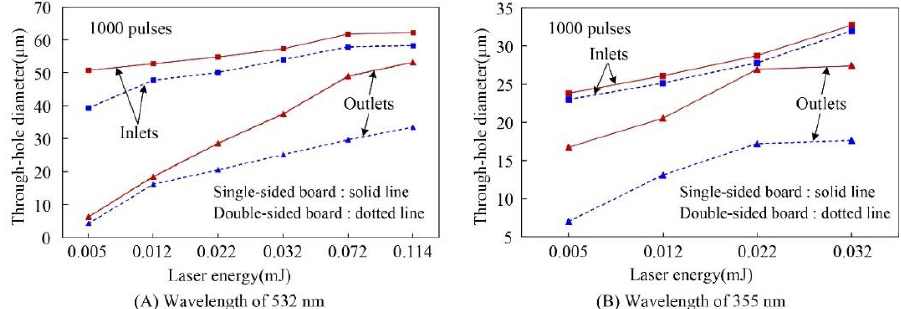
Figure 3. Hole diameter versus energy with different wavelengths.